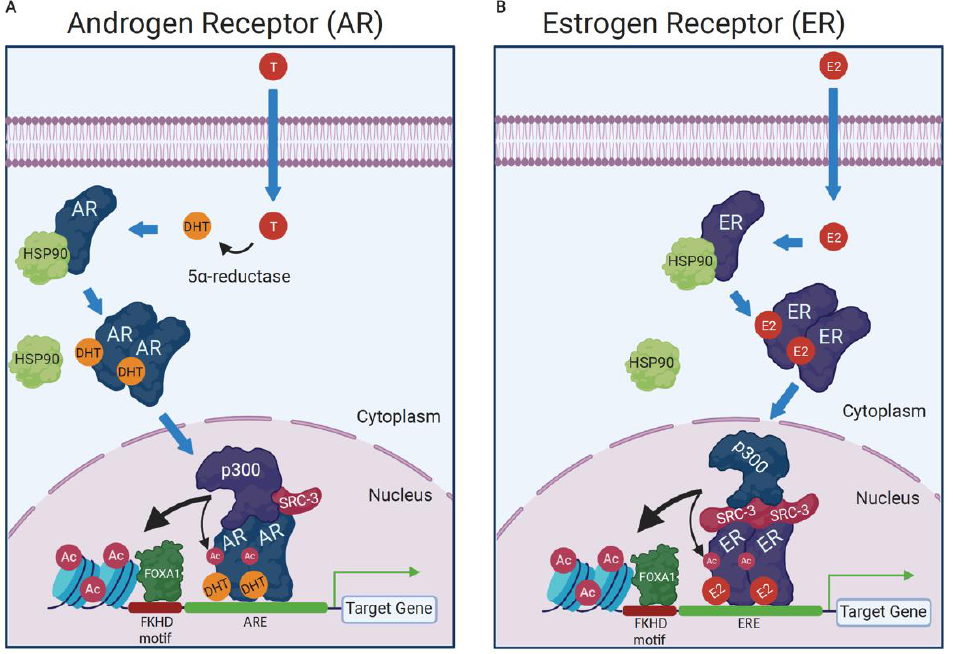
Figure 3. Nuclear Hormone Receptor Signaling. ( A ) An overview of the androgen receptor signaling cascade and formation of the AR activation complex at the ARE in AR target genes. ( B ) An overview of the estrogen receptor signaling cascade and formation of the ER activation complex at the ERE in ER target genes. Ac: lysine acetylation; ARE: androgen response element; DHT: 5 α -dihydrotestosterone; E2: 17 β -Estradiol; ERE: estrogen response element; FKHD: forkhead motif; HSP: heat shock protein; T: